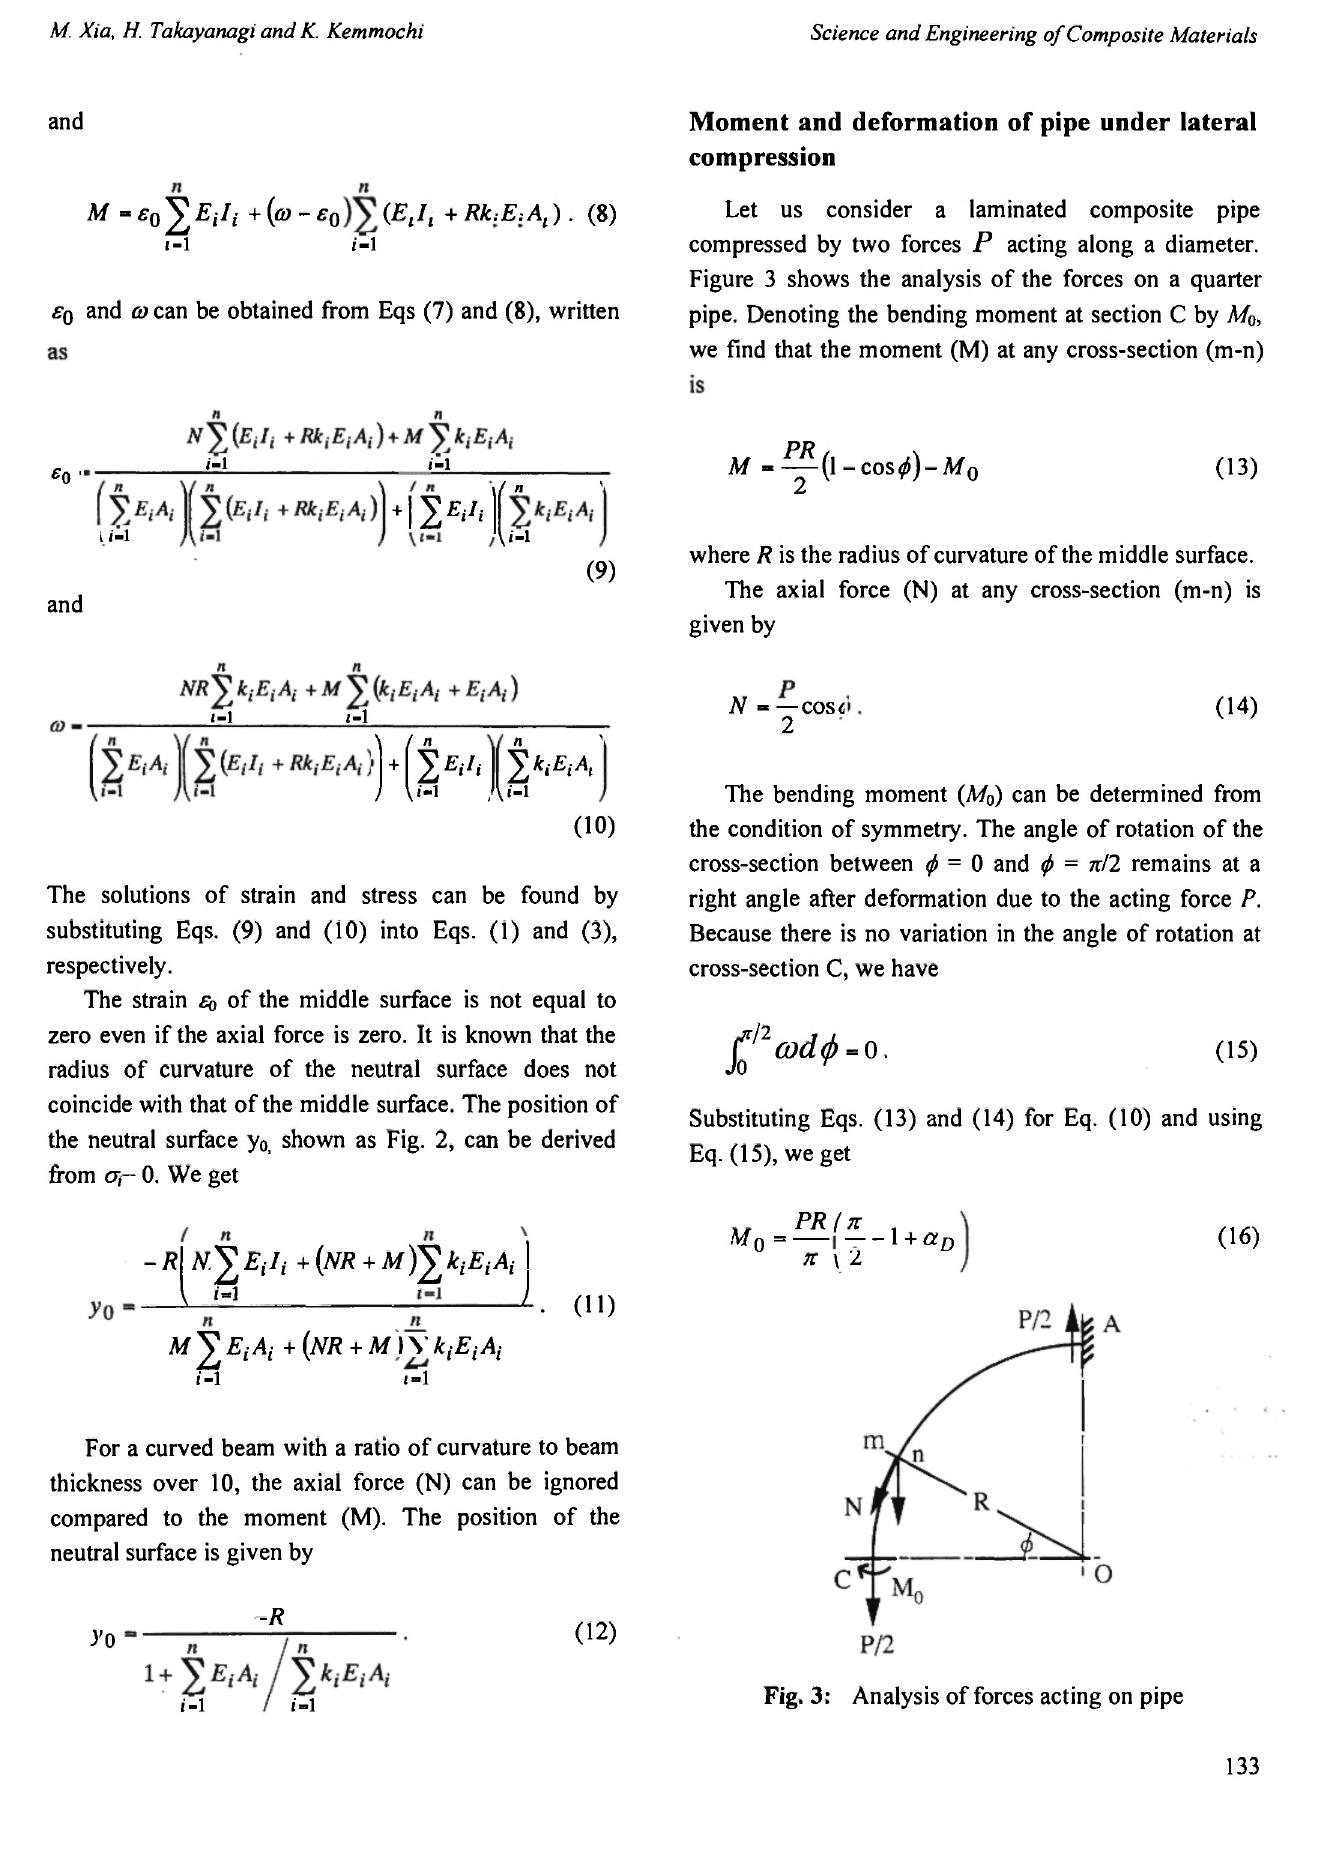
Fig. 3: Analysis of forces acting on